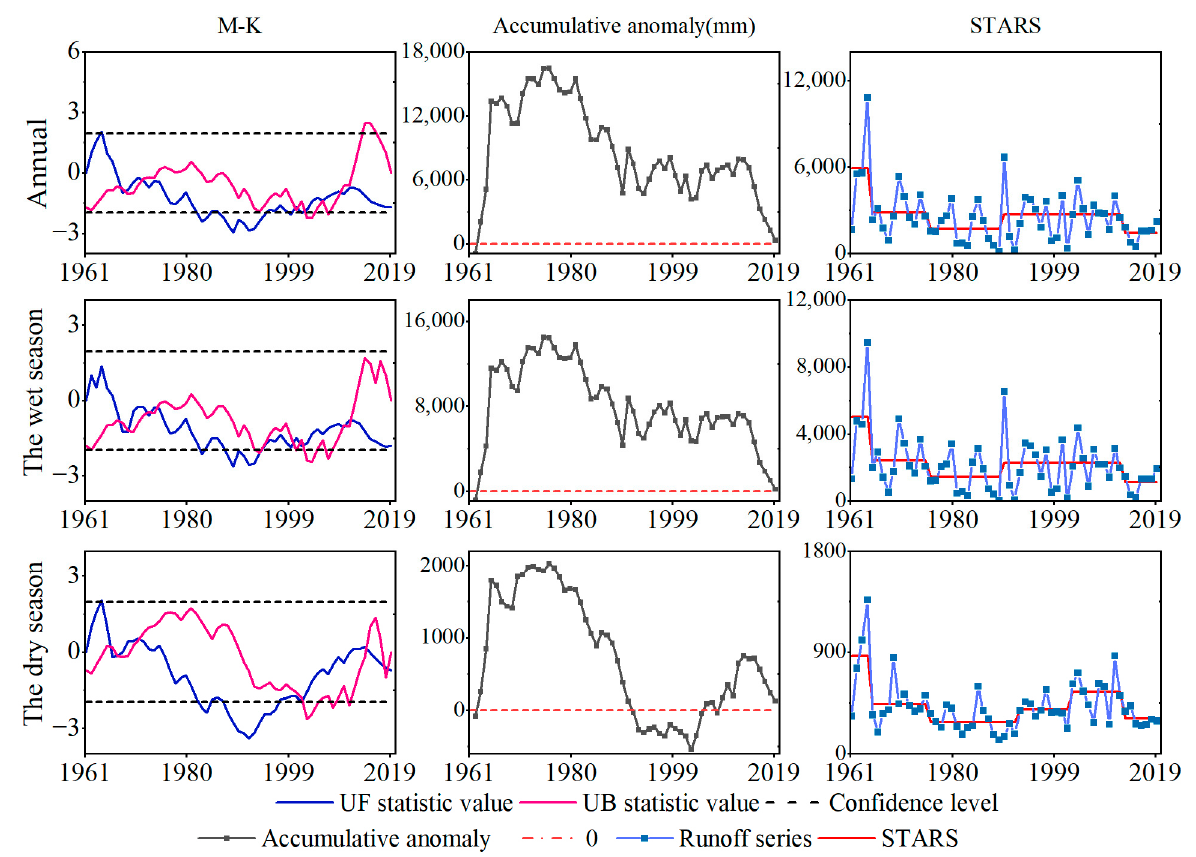
Figure 6. The mutation analysis of the runoff at Laiwu station. (2) Runoff at Beiwang Hydrological Station (Figure